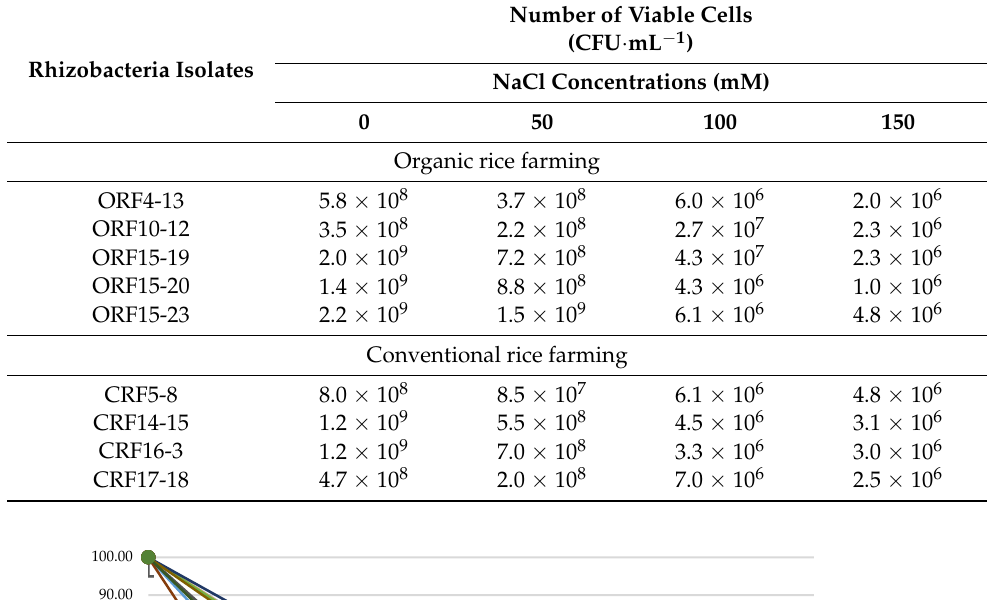
Table 4. Number of viable rhizobacteria cells under different NaCl concentrations in Hoagland solution at 30 days after inoculation.